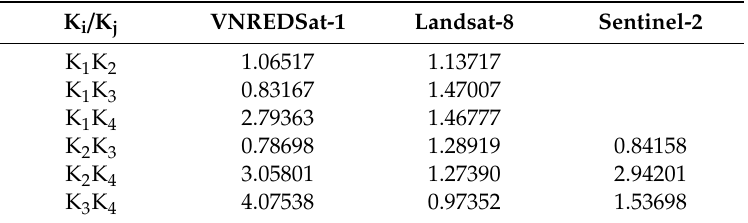
Table 4. Band pair K i / K j ratios.